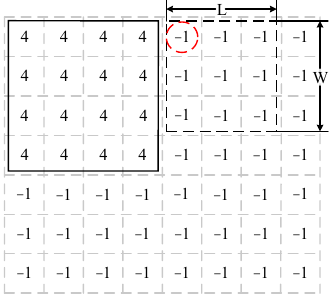
Figure 6. Schematic diagram of the next node screening method.